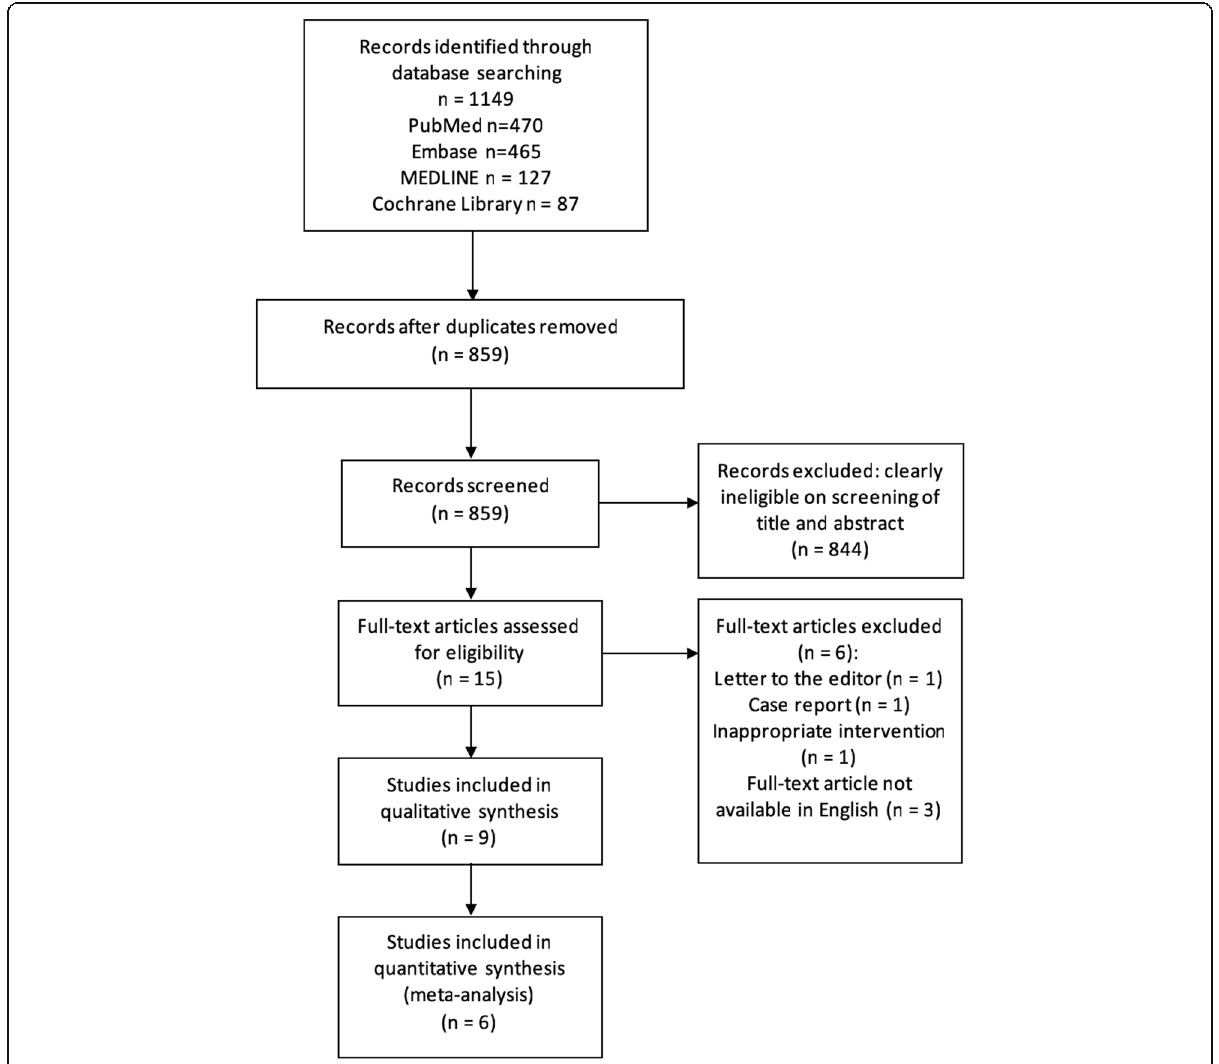
Fig. 1 A PRISMA flow diagram outlining each phase of the systematic review